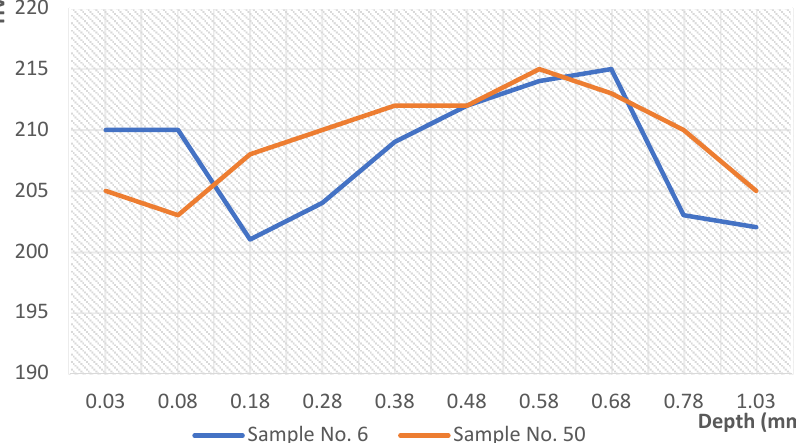
Figure 10. Distribution of microhardness from the surface to the sample core for samples No. 6 (burnishing with lubricant/MQL) and No. 50 (dry burnishing).